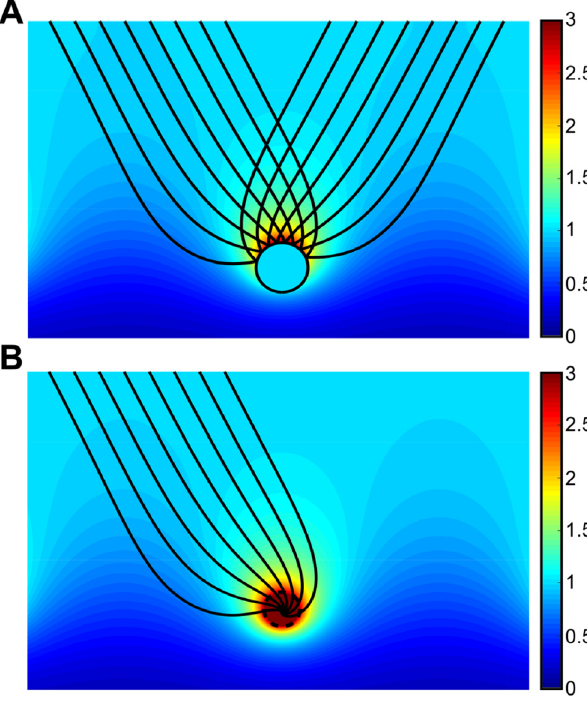
Figure 2: Contour plot of refractive index distribution of transformed medium and the corresponding retrieved trajectory of light illuminating (A) a PEC elliptical defect embedded in an illusion deviceand(B)theblackholewiththepositioninthesamerefractive index indicated by the dashed black